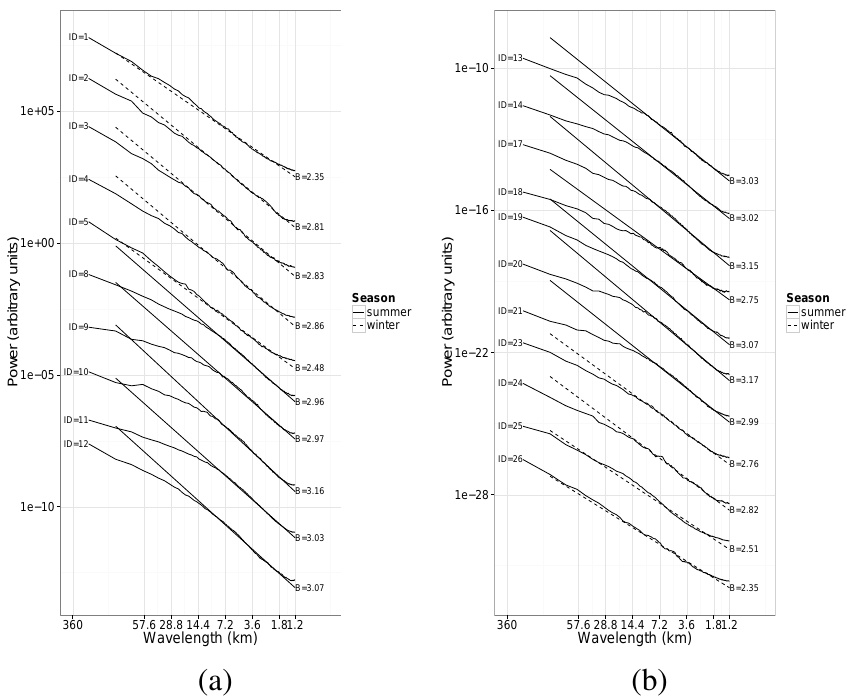
Figure 3. The power spectra of all rainstorms, up to a range of 180km from the radar, for images which have more than 10% active pixels and storms with at least 10 valid images. The storm spectra are found by averaging together the spectra of each of the images. The number at the end of each line is the slope β , whereas the number at the beginning is an ID number for each of the storms. Summer storms show a higher slope β , and a short range of scaling than do winter storms. This is possibly explained by the generally smaller scale of convective summer precipitation. The short scaling break at the smallest scales is likely a result of non-raining areas. D i